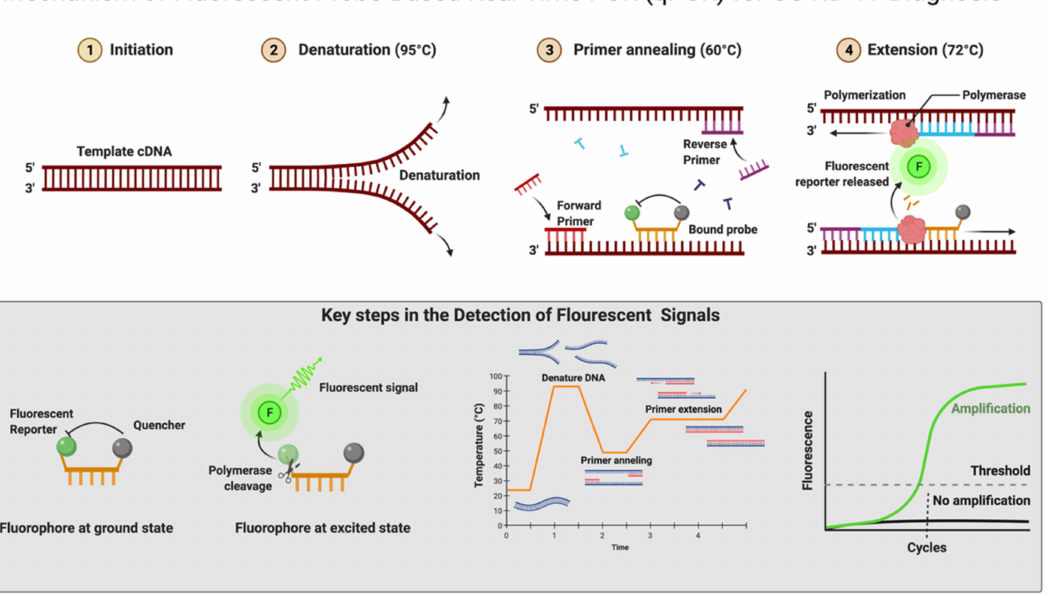
Figure 4. Mechanism of fluorescent probe-based real-time PCR (qPCR) for COVID-19 diagnosis. Figure was created with Biorender.com on 20 May